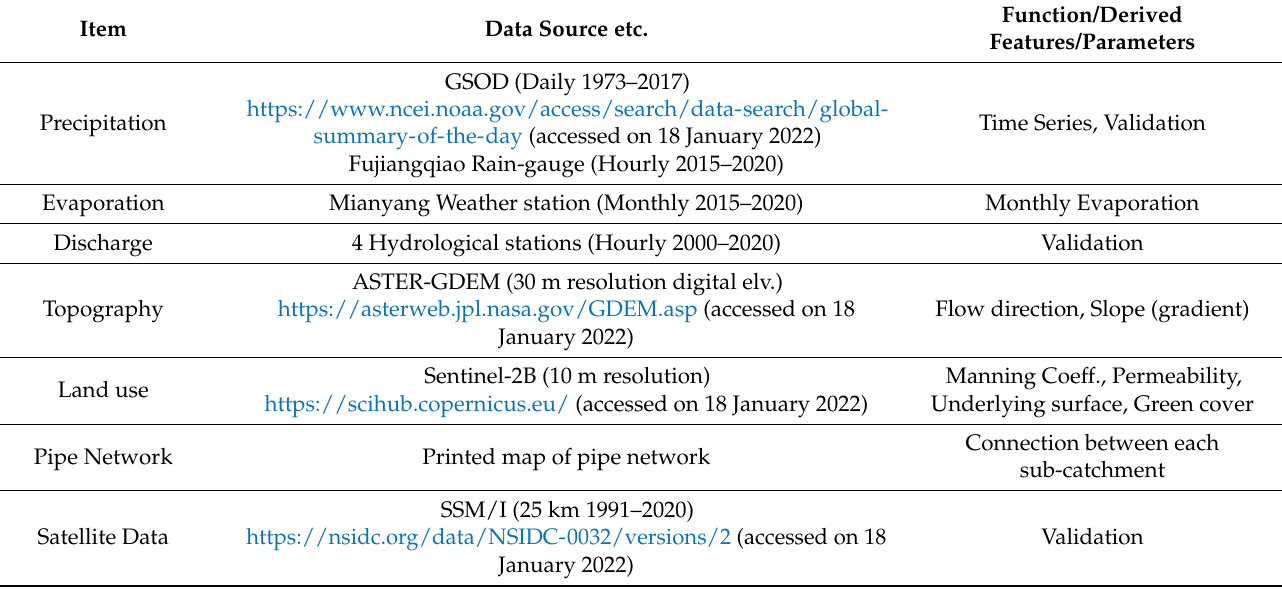
Table 1. Data list for SWMM and